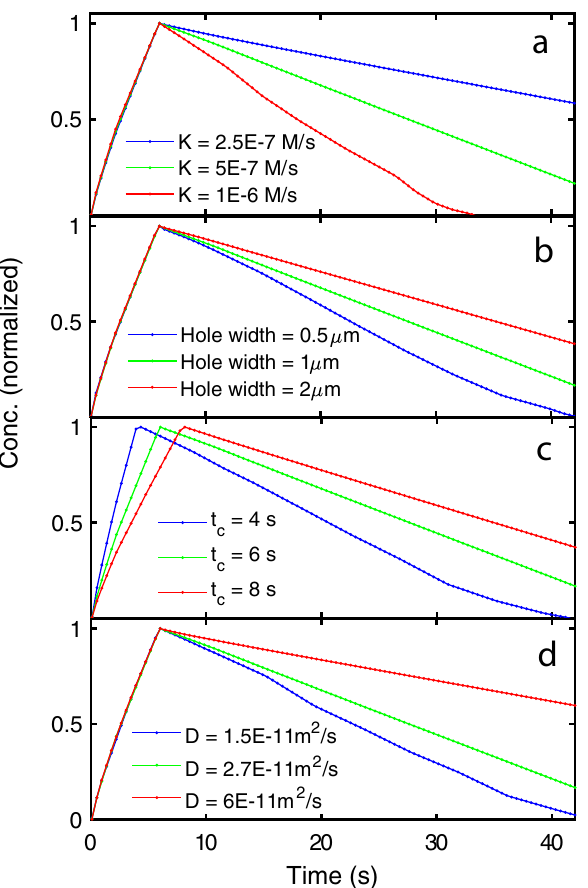
Figure 6. Variation of the mean calcium concentration in the simulation box upon variation of selected parameters in the model ( a – d ). The values of the varied parameter are indicated in the legends while the non- varied parameters have the values used in Fig. 5. The time dependence of the mean concentration was in all cases normalized to the peak maximum. It is noted that variation of the pump rate K ( a ), the hole width w h ( b ) and the diffusion coefficient D ( d ) affect only the slope of decay after t c . Variation of the hole closure time t c ( c ) affects both the position of the peak maximum and the decay slope. The peak maximum is identical to t c within the numerical